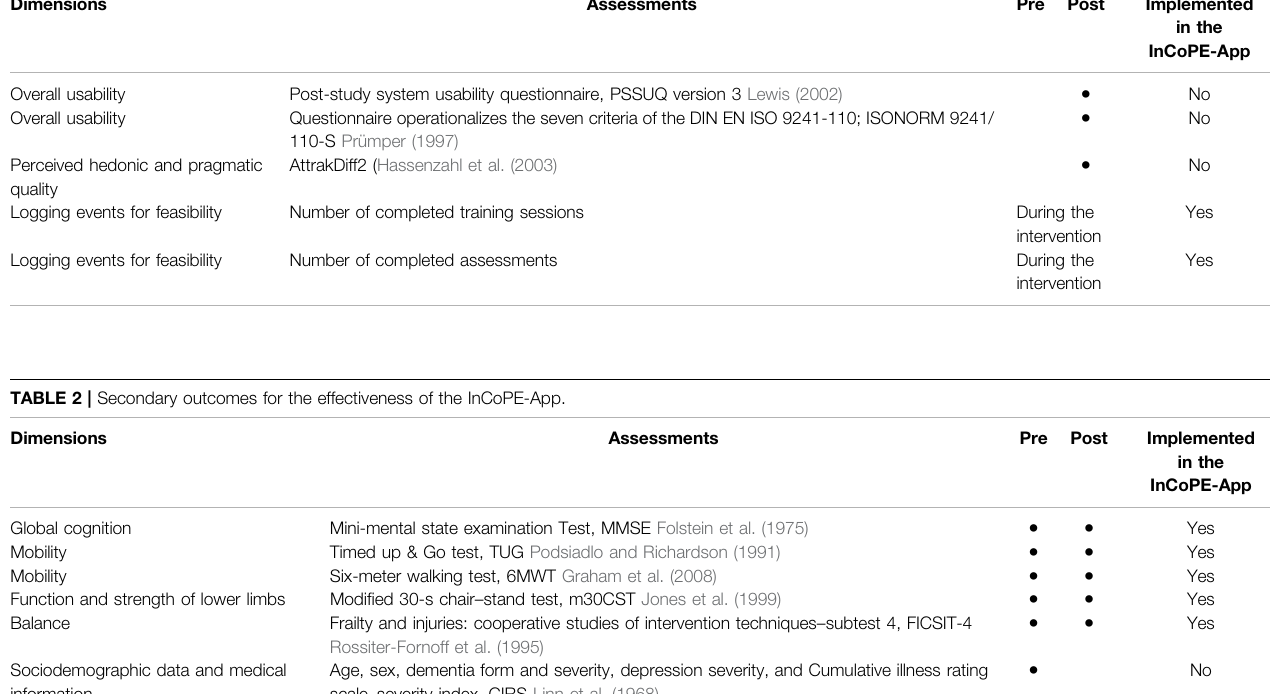
TABLE 1 | Primary outcomes for usability and feasibility of the InCoPE-App. Dimensions